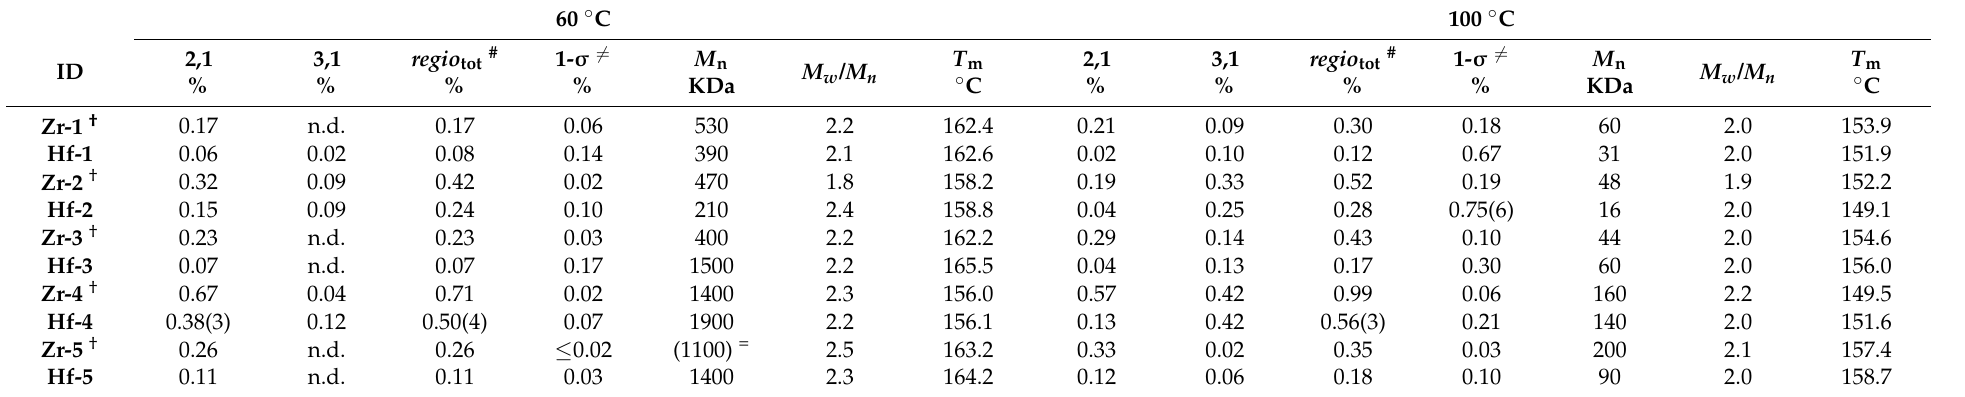
Table 1. Results of the characterization of iPP samples prepared at T p = 60 ◦ C and p (C 3 H 6 ) = 6.6 bar or T p = 100 ◦ C and p (C 3 H 6 ) = 7.9 bar with the five catalyst pairs of Figure 1 ( M-1 to M-5 ; see text for